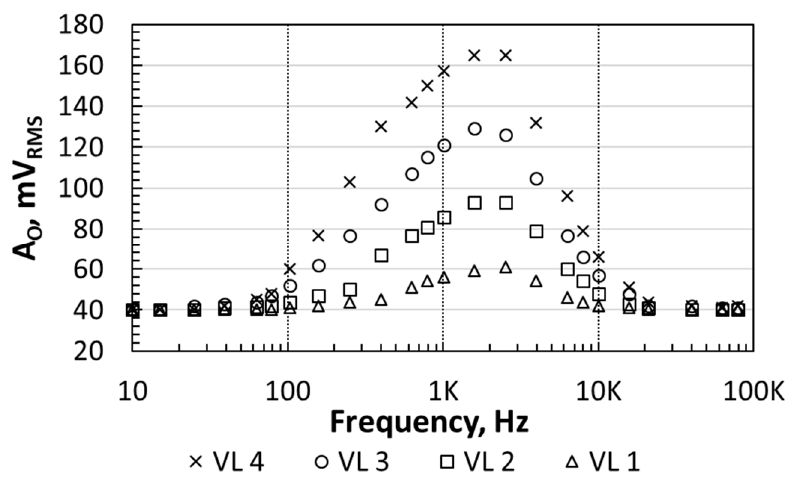
Figure 8. Sensor’s output voltage as a function of the frequency for four different heater bias. Measurements done with the